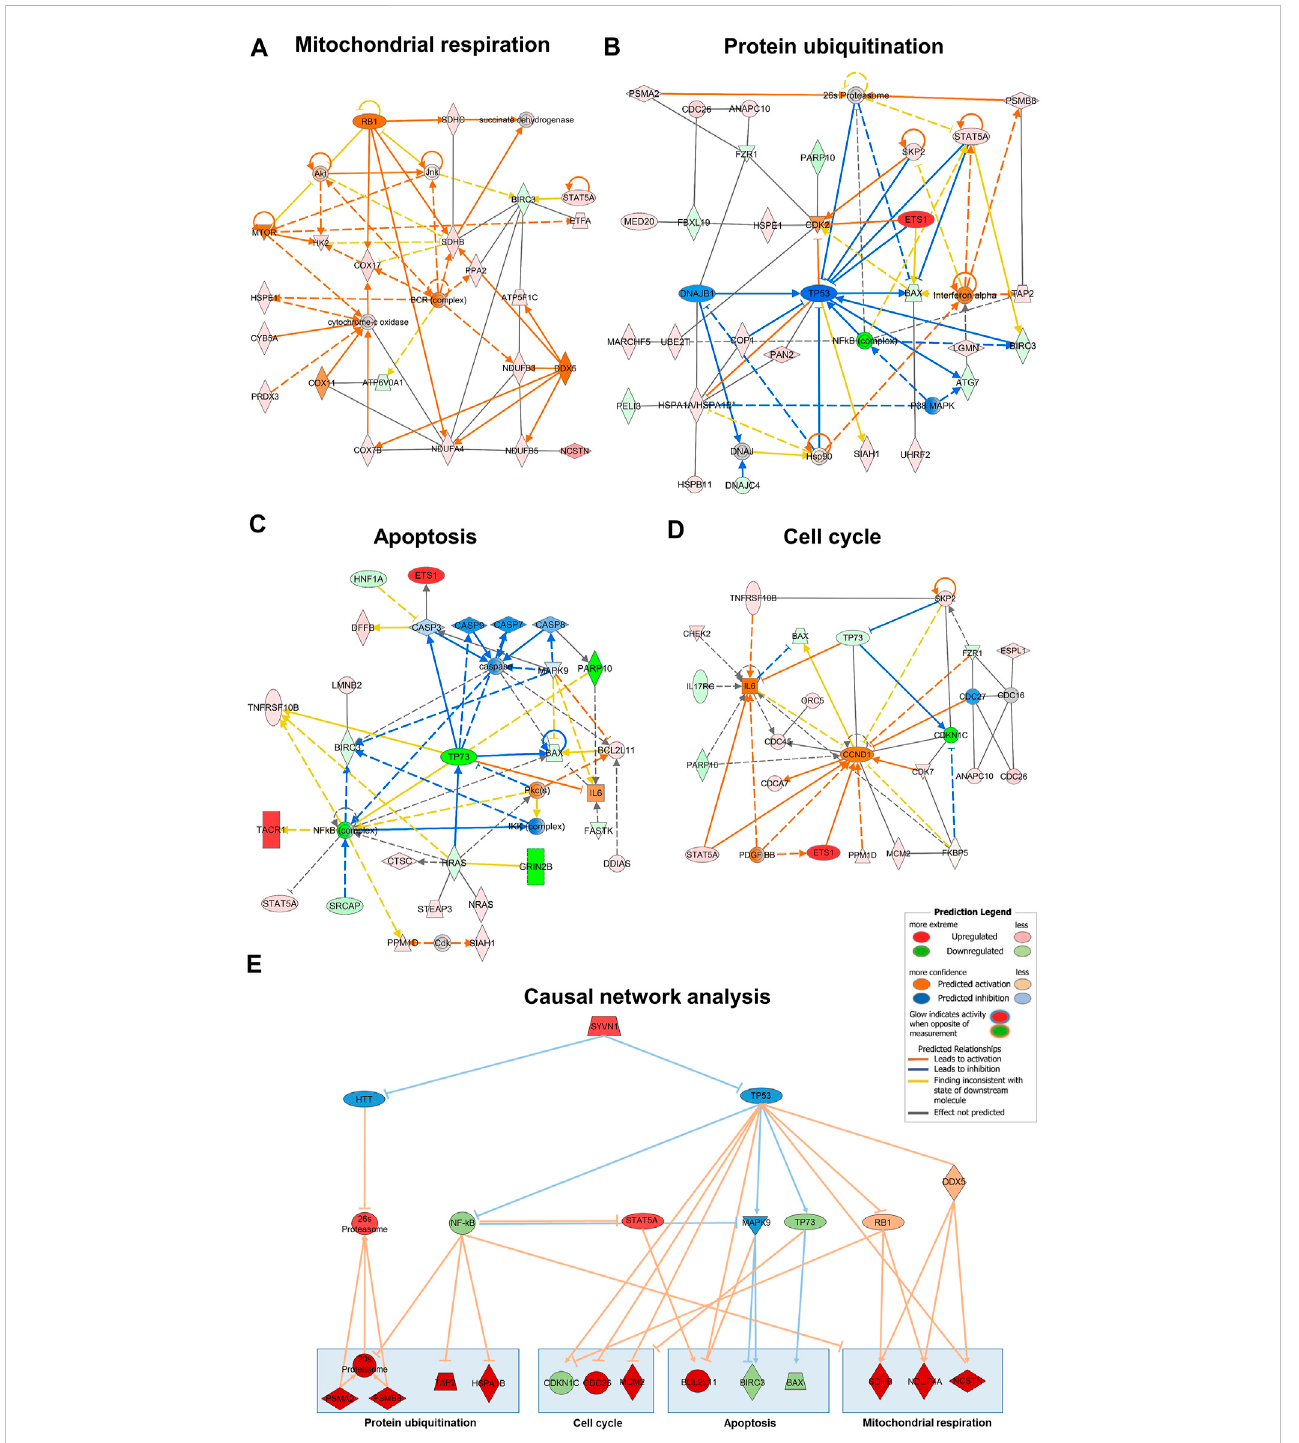
FIGURE 5 Gene interaction network map generated with IPA for mitochondrial respiration (A) , protein ubiquitination (B) , apoptosis (C) and cell cycle (D) pathways. Genes associated with one of the four pathways are represented by nodes with their shape representing the type of molecule/functional class. The causal network results of the 456 DEG identi fi ed the master regulator SYVN1 targeting the highest number of molecules in our dataset through the intermediate regulatorsHTTandTP53 (E) .Networkincludesupanddownregulationofdownstreamdatasetmolecules.Nodesinredareupregulatedinuntreated/PA +HK4-treatedHepG2cells,orangenodesarepredictedtobeactivatedfromIngenuityknowledgebase,greencolorednodesshowdownregulationandblue ones are predicted to be inhibited. Orange lines between the nodes indicate an activating relationship, blue lines an inhibition. Pointed arrowheads indicate thatthedownstreamnodeisexpected tobeactivatediftheupstreamnodeconnectedtoitisactivated, whilebluntarrowheads indicatethat thedownstream node is expected to be inhibited if the upstream node that connects to it is activated. Predicted legend is shown on the right